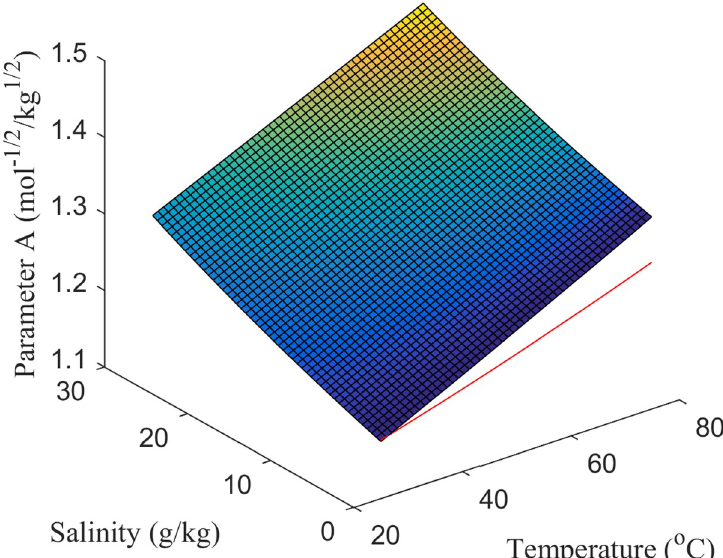
Fig 1. Calculation of the parameter A . The red line refers to the temperature-dependent function (Eq 5), whereas the surface is the temperature/salinity-dependent function (Eq 6).